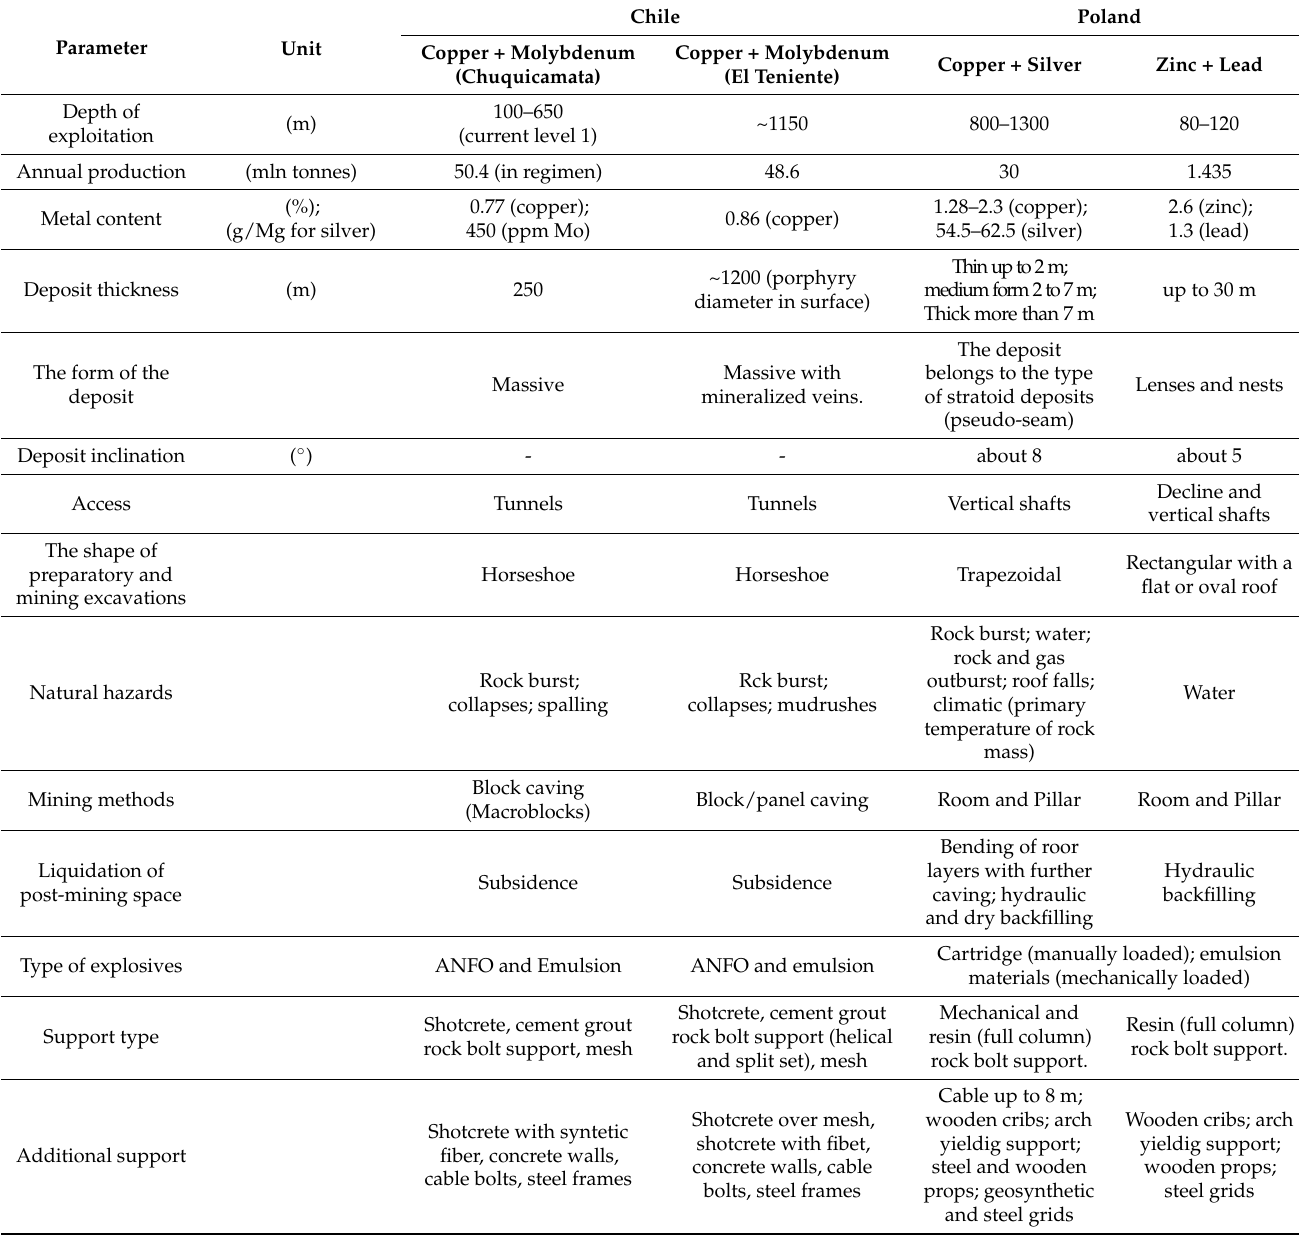
Table 1. Comparison of mining and geological parameters for underground mining of selected ore deposits (copper and silver, zinc and lead) in Chile and